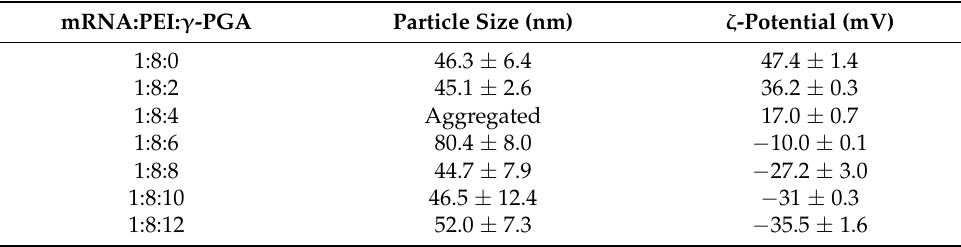
Figure 2. In vitro protein expression of the mRNA/PEI complexes at various charge ratios (1:2, 1:4, 1:6, 1:8, 1:10, 1:12, and 1:14) in B16 cells. B16 cells were incubated for 2 h with each complex. In vitro protein expression of the complexes was determined in the absence of fetal bovine serum. At 24 h following the addition of the complexes, luciferase activity in the cells was evaluated. Data represent the mean ± S.E. ( n = 3). * p < 0.05, ** p < 0.01 vs. naked mRNA. Table 2. Particle sizes and ζ -potentials of mRNA/PEI8/ γ -PGA